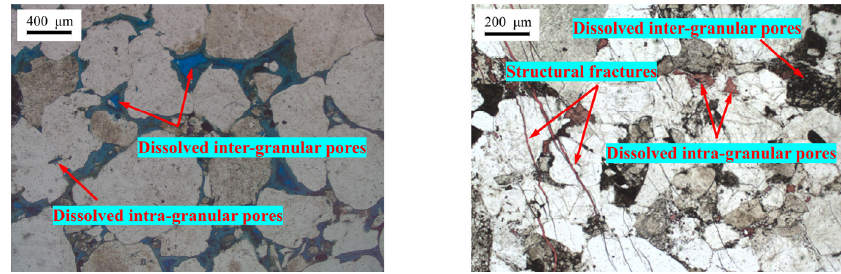
Figure 1. Thin sections of tight sandstone cores in the study area of the Ordos Basin. In the schematic illustration of the tight sandstone (Figure 2a), the total porosity ( φ ) of tight sandstone is divided into the spaces occupied by round pores ( φ p ) and